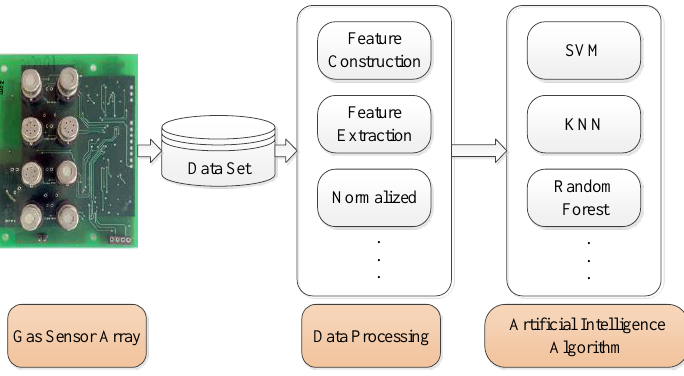
Figure 1. Diagram of the machine olfactory system. SVM: support vector machine KNN: K-nearest neighbour.